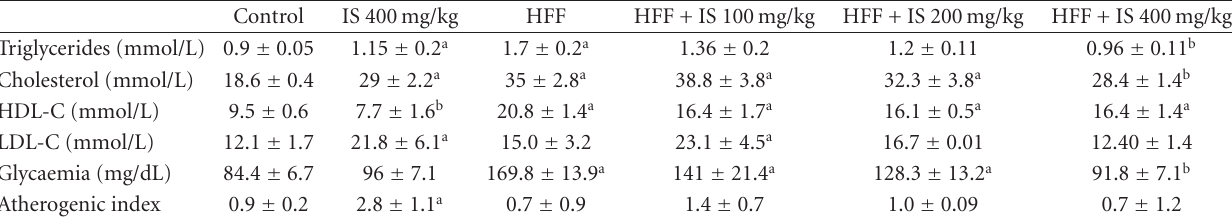
Table 3: Glycaemia and lipid profile in male mice fed HFF and/or IS for 8 weeks. Control